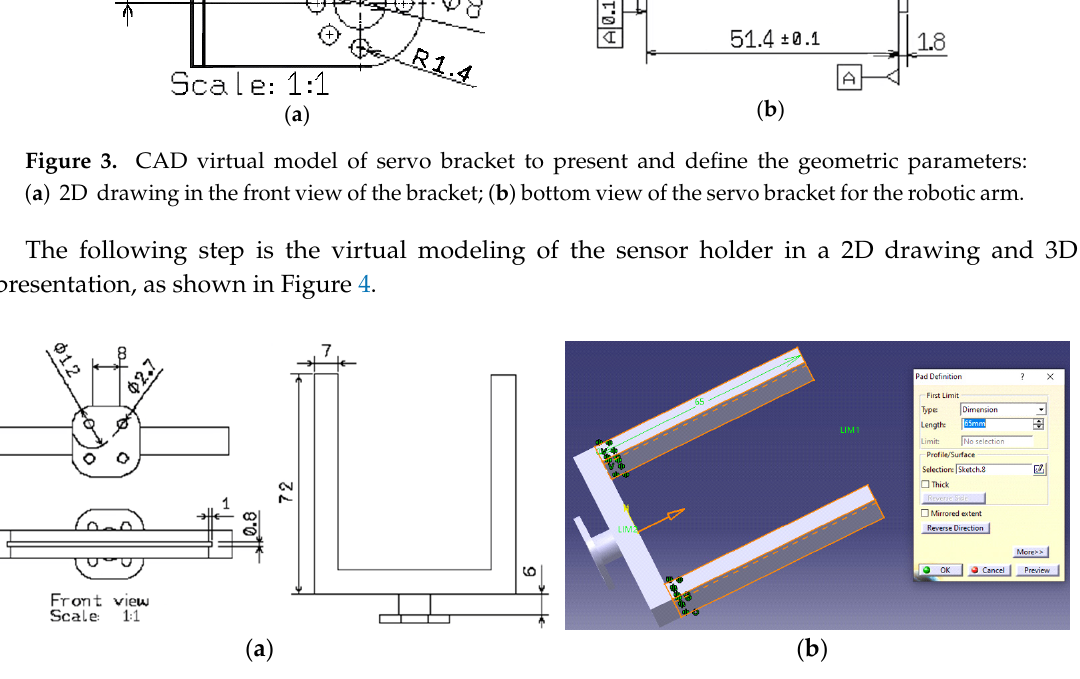
Figure 4. Virtual development of the end part of the robotic arm sensor holder with Computer Aided Design (CAD): ( a ) 2D drawing of the sensor holder; ( b ) representation of a 3D model designed as a mine detection sensor holder.